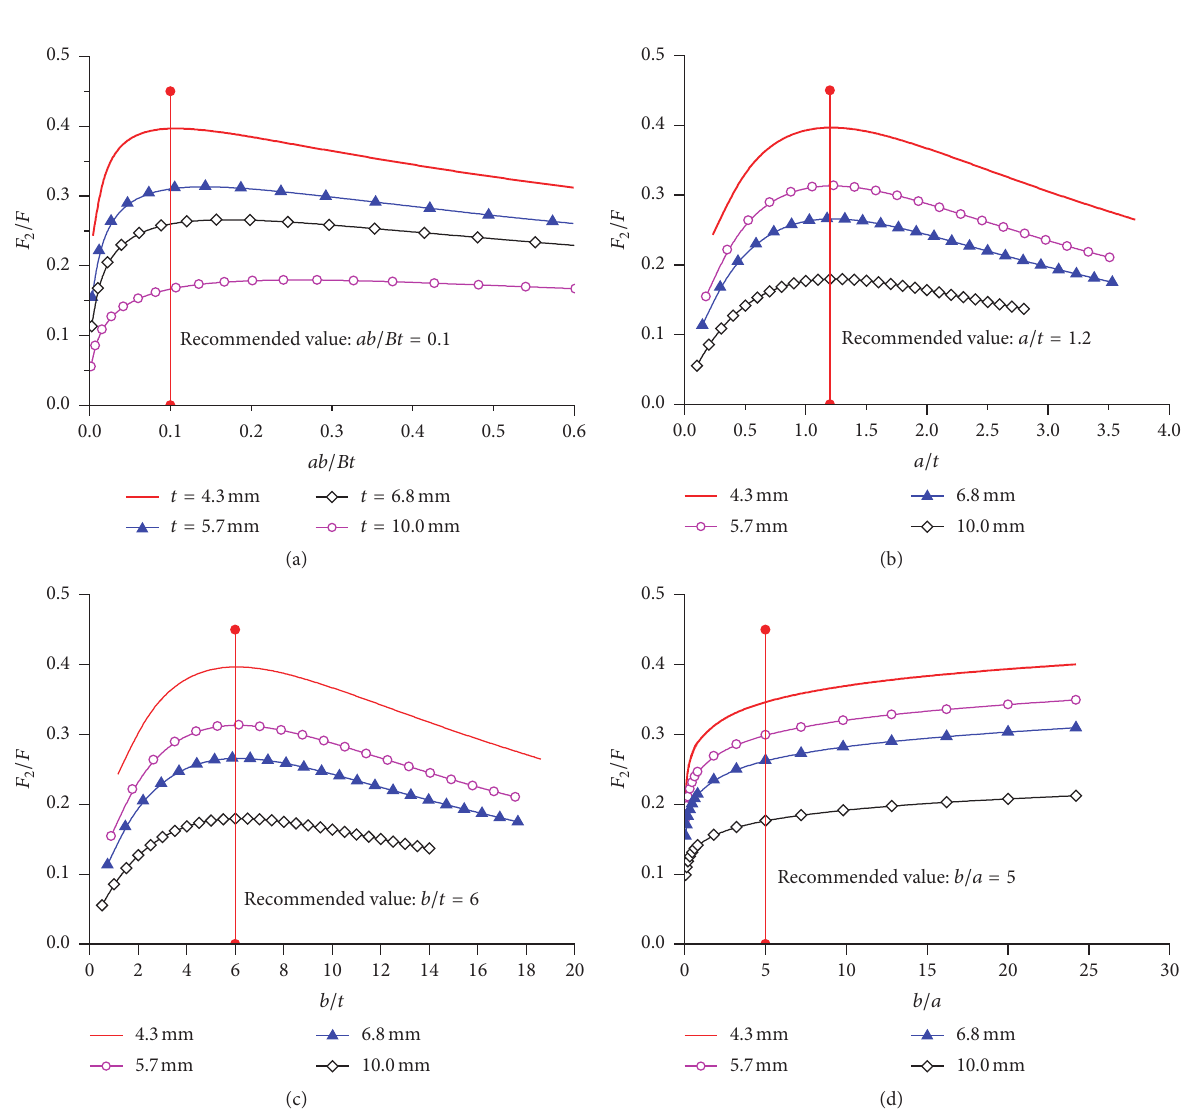
Figure 13: The relation between the value of 𝐹 2 / F and the geometric dimensional parameters of stiffeners: (a) 𝐹 2 /F-ab/Bt , (b) 𝐹 2 /F-a/t , (c) 𝐹 𝐹 2 /F-b/t , and (d) 2 /F-b/a